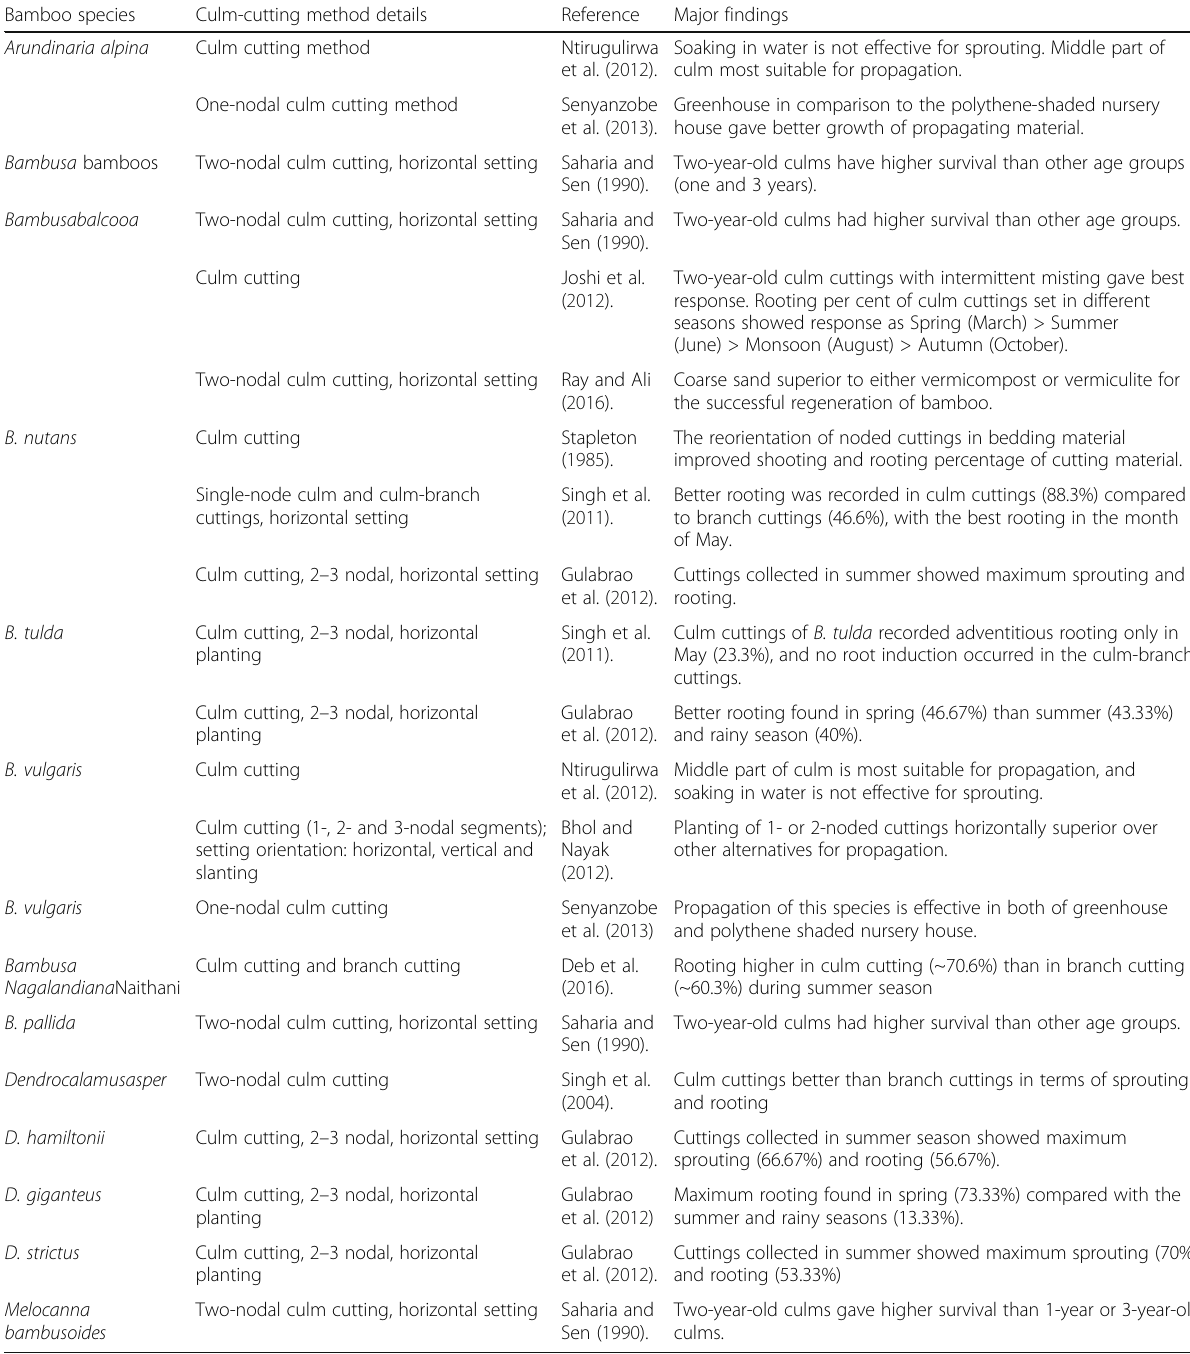
Table 1 Summary of major findings to date on culm-cutting-based propagation of bamboo Bamboo